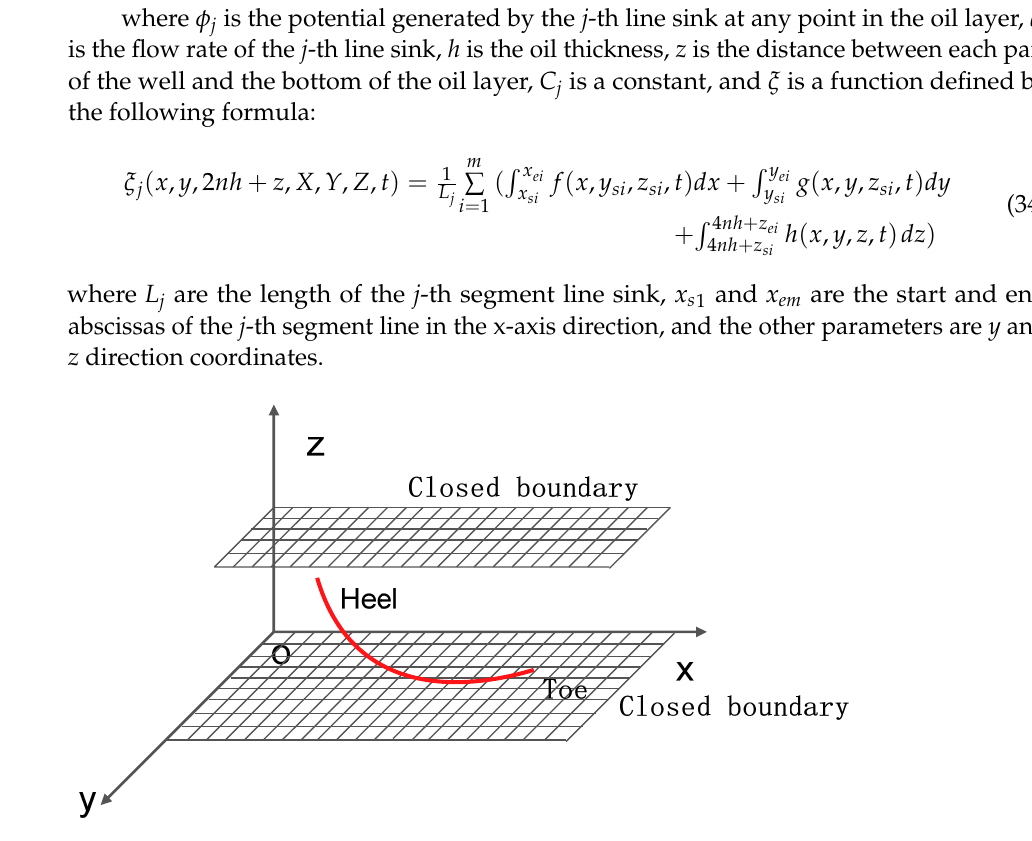
Figure 2. Schematic diagram of the horizontal well in the upper and lower closed boundary reservoir.